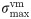
Receiver operating characteristic (ROC) curves showing true positive rates (TPR) over false positive rates (FPR) and area under the ROC curve (AUC) scores for dmax, σmaxvm, RPI, PRRI and ℙrupt.